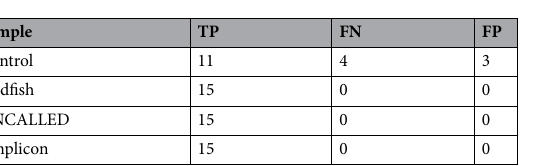
Table 2. Variant-calling results in TB gene regions. The variant-calling performance of different samples at the 19 gene or locus regions defined by Tafess et al. Variant calling was conducted using the Clair3v0.1-r12 guppy5 model. TP true positive, FN false negative, FP false